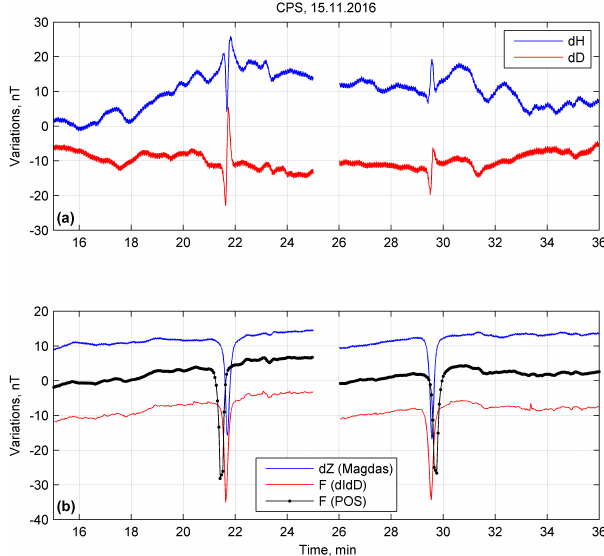
Figure 7. Example of noise in the form of jumps in the data from the dIdD GSM-19FD magnetometer at the Cape Schmidt observa- tory. (a) Daily records of F of dIdD and scalar Overhauser mag- netometer POS-1; (b) detailed fragment from (a) with a jump; (c) differences d F = F (dIdD)- F (POS) in which natural geomagnetic variations are removed; (d) the same as (c) , but jumps in F (dIdD) are removed.